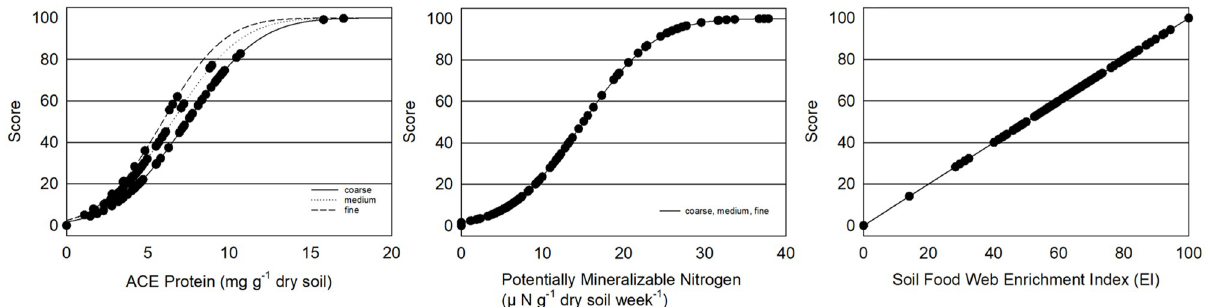
Fig 4. Indicators of microbially available N: ACE protein (mg g -1 dry soil), potentially mineralizable N ( μ N g -1 week -1 ), and soil food web enrichment index for 101 Central Washington orchard field soils.